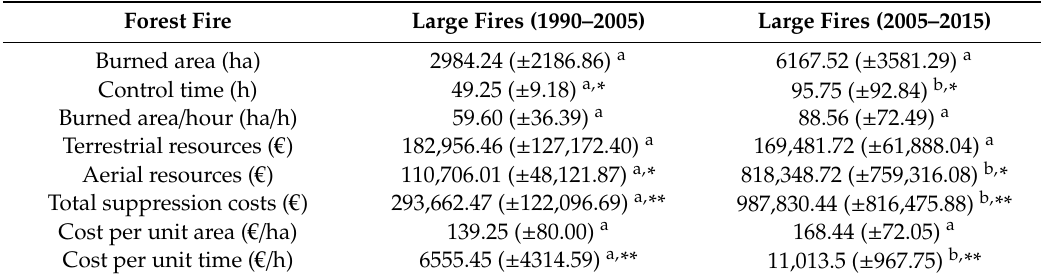
Table 8. Average suppression costs from large fire experiences in Andalusia